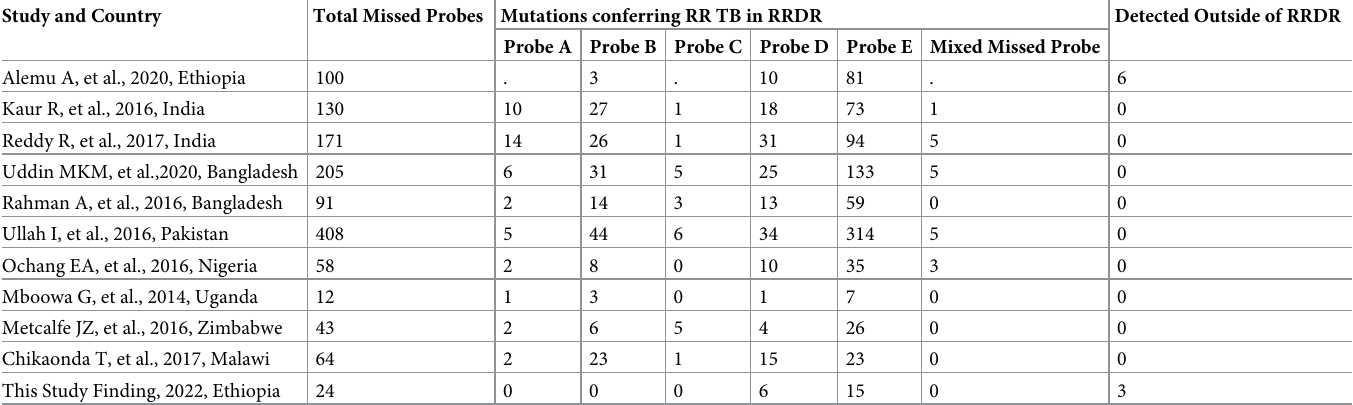
Table 4. Comparison of this study with the prevalence of missed probes conferring RR TB using the GeneXpert MTB/RIF assay in 10 studies conducted in different countries. Study and